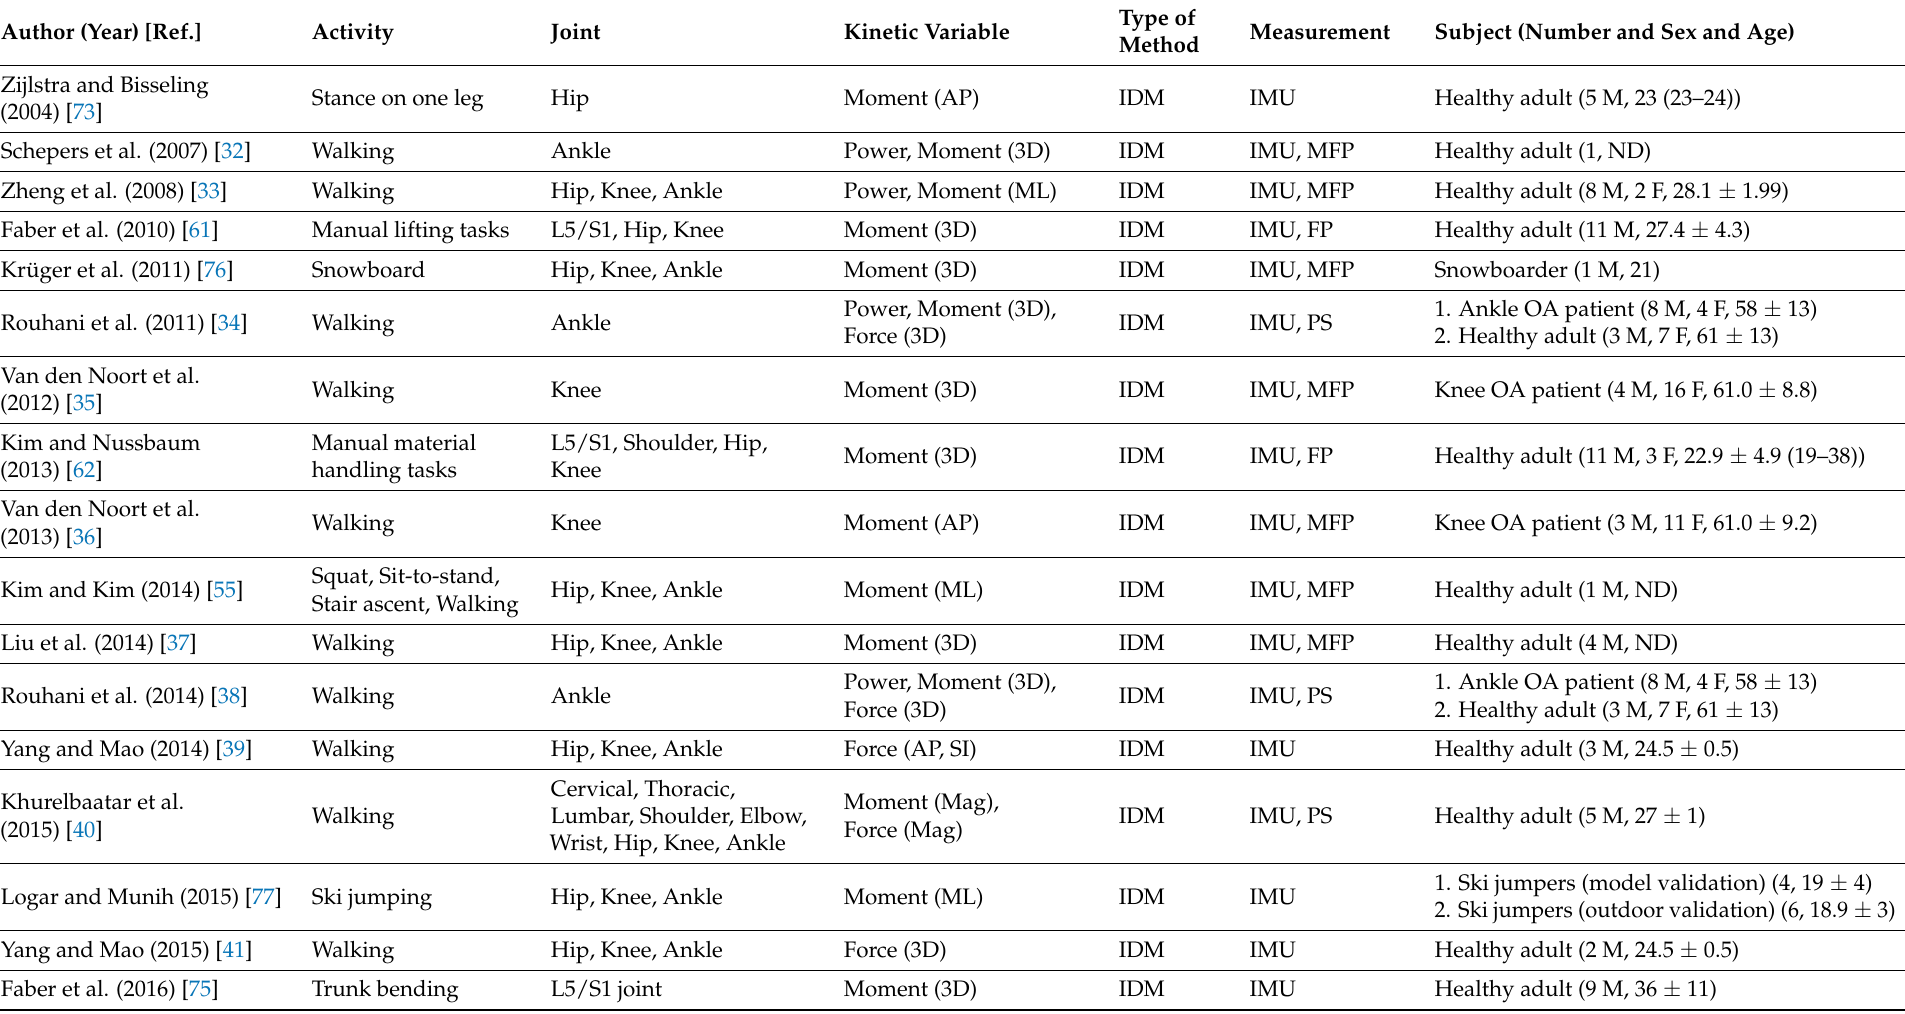
Table 2. Characteristics of